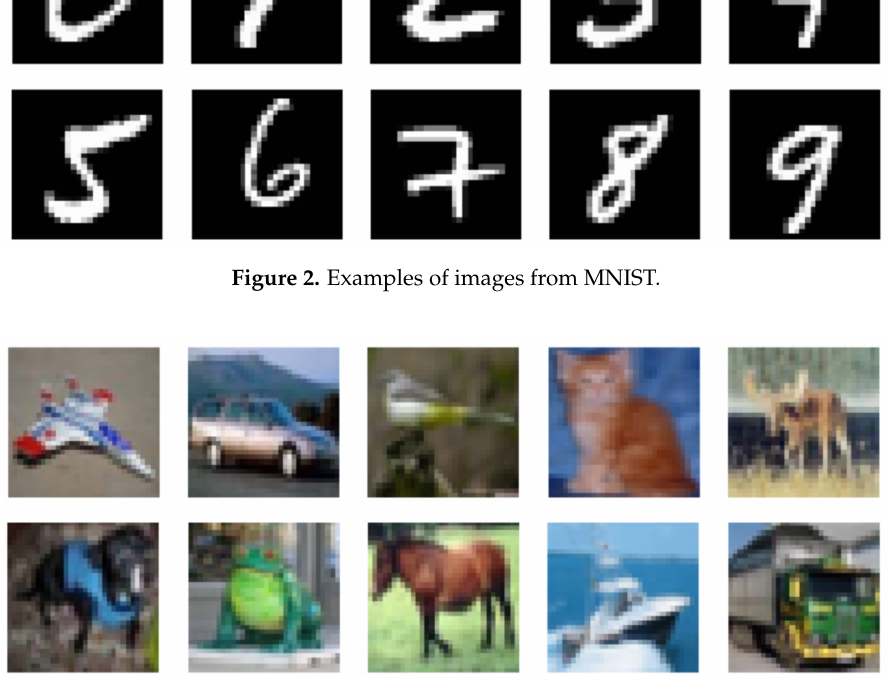
Figure 3. Examples of images from